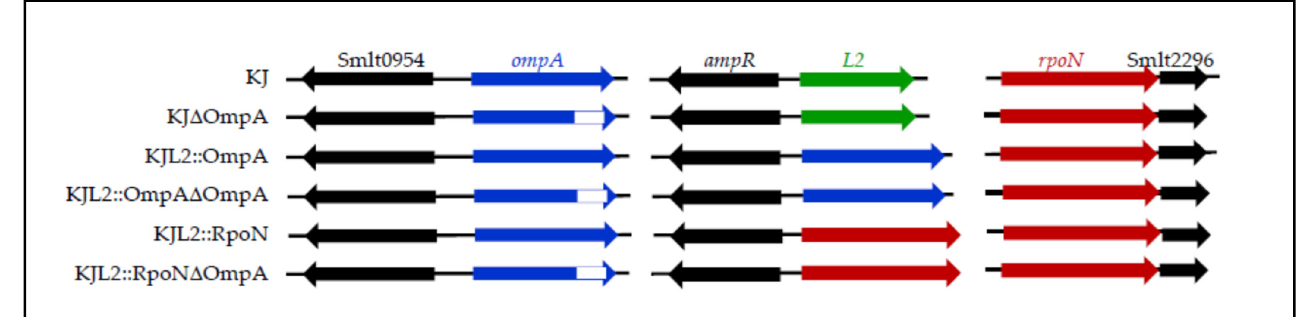
Figure 1. Genomic organization of KJ and its derived ompA -associated constructs. The orientation of the gene is indicated by the arrow. The white box indicates the deleted region of the ompA gene.